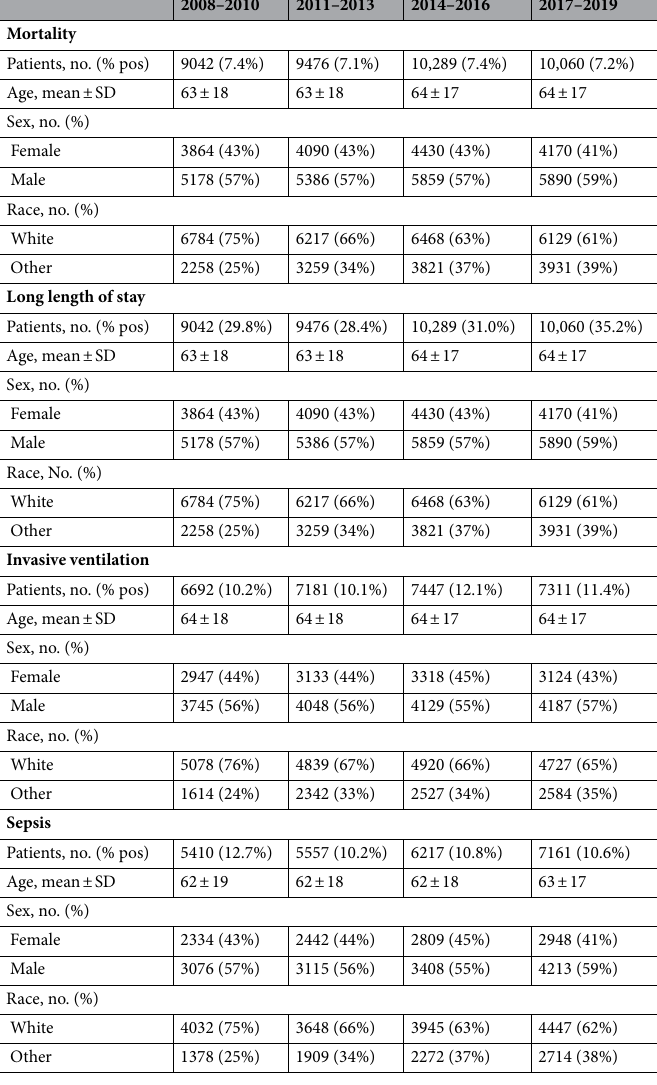
Table 1. Cohort characteristics by year group. pos: positive labels; SD: standard